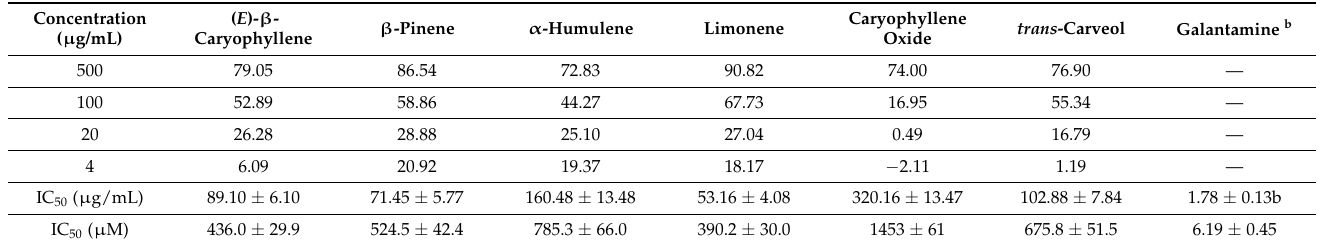
Table 3. Acetylcholinesterase inhibitory activity of main components of the essential oils of Callicarpa, Premna, Vitex , and Karomia species from Vietnam a